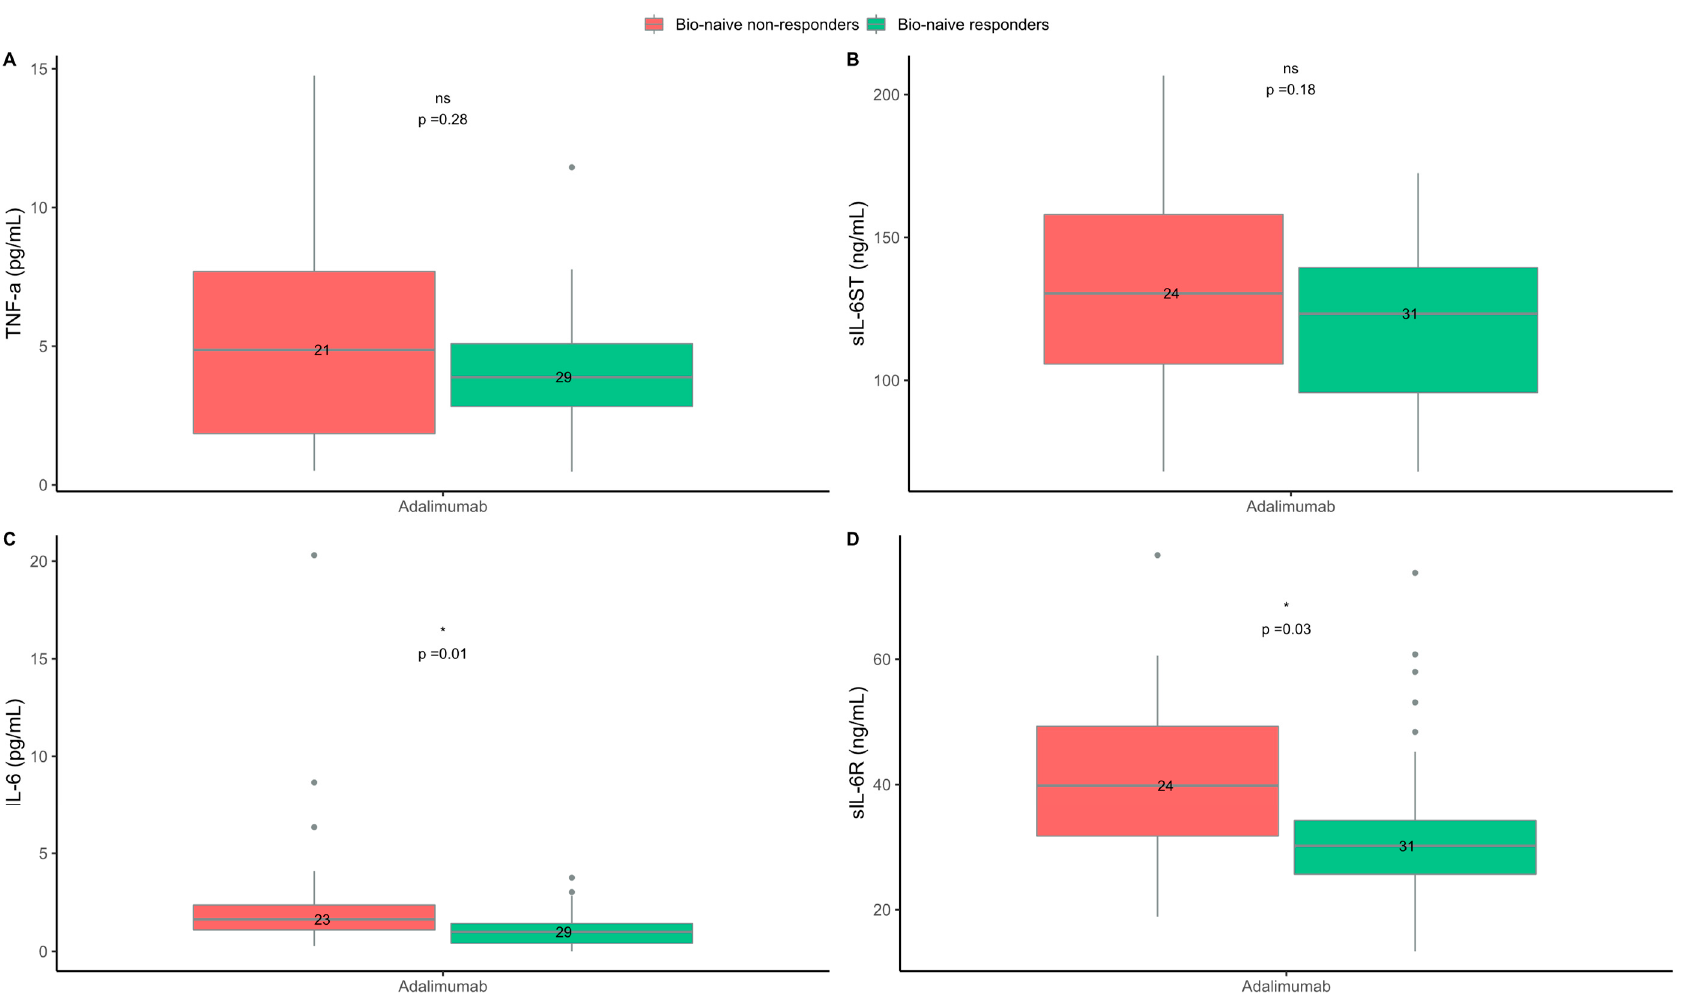
Figure 4. Blood cytokine levels at baseline in bio-naive responders and non-responders to treatment with adalimumab. ( A ) Tumor necrosis factor (TNF)- α . ( B ) Soluble interleukin-6 signal transducer (sIL-6ST). ( C ) Interleukin-6 (IL-6). ( D ) Soluble interleukin-6 receptor (sIL-6R). Responders = psoriasis area and severity index (PASI) ≤ 2 three months after treatment start. Non-responders = PASI > 2 three months after treatment start. ns = non-signi fi cant. * p < 0.05.